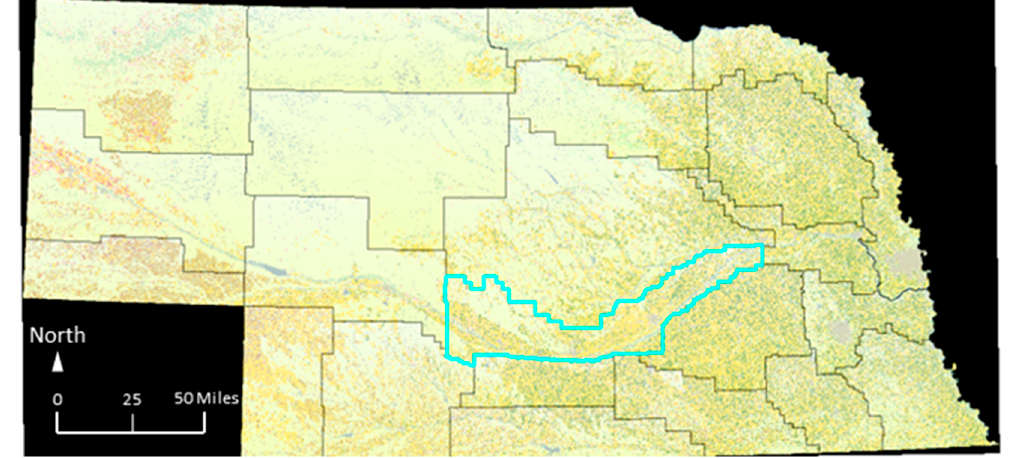
Figure 1. Map of study areas (Central Platte Natural Resources District in Nebraska). (Source: USDA Natural Resources Conservation Service: Geospatial Data Gateway, 2014) [28].